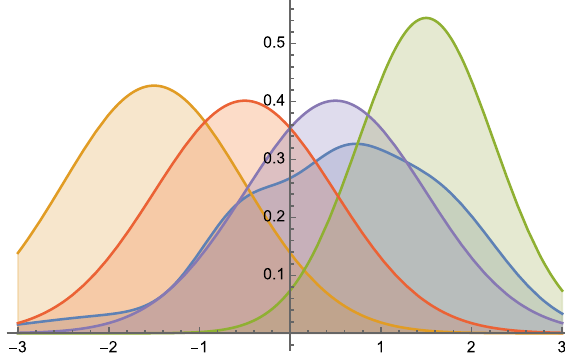
Fig. 13 Example 5, f ( x )/µ (in blue) superimposed with the four pdfs used for MIS integration